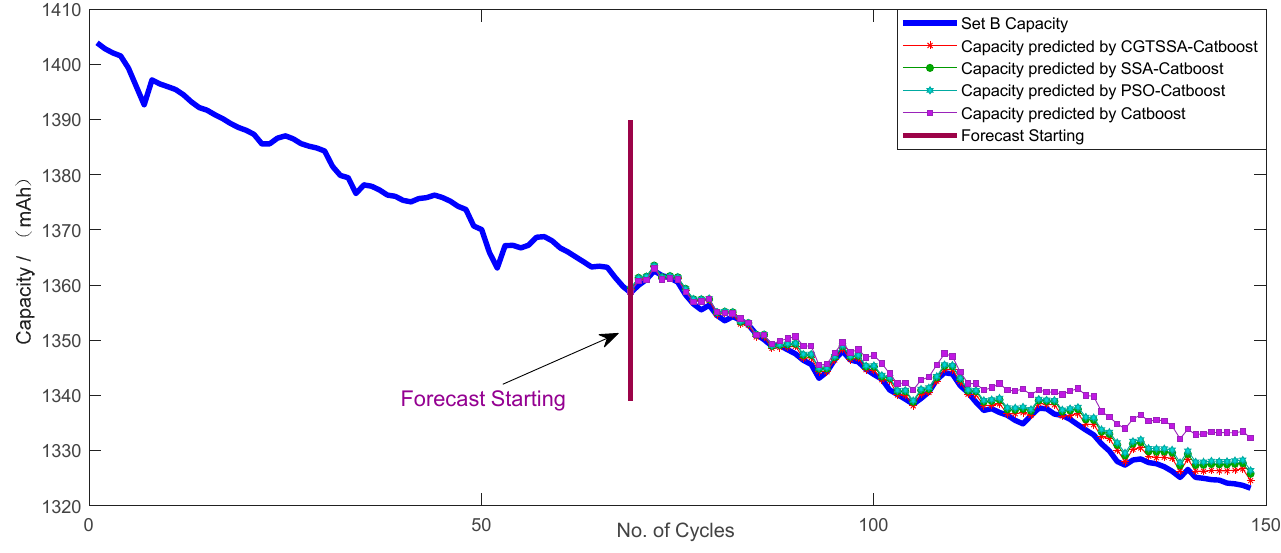
Figure 9. Prediction results of dataset B.